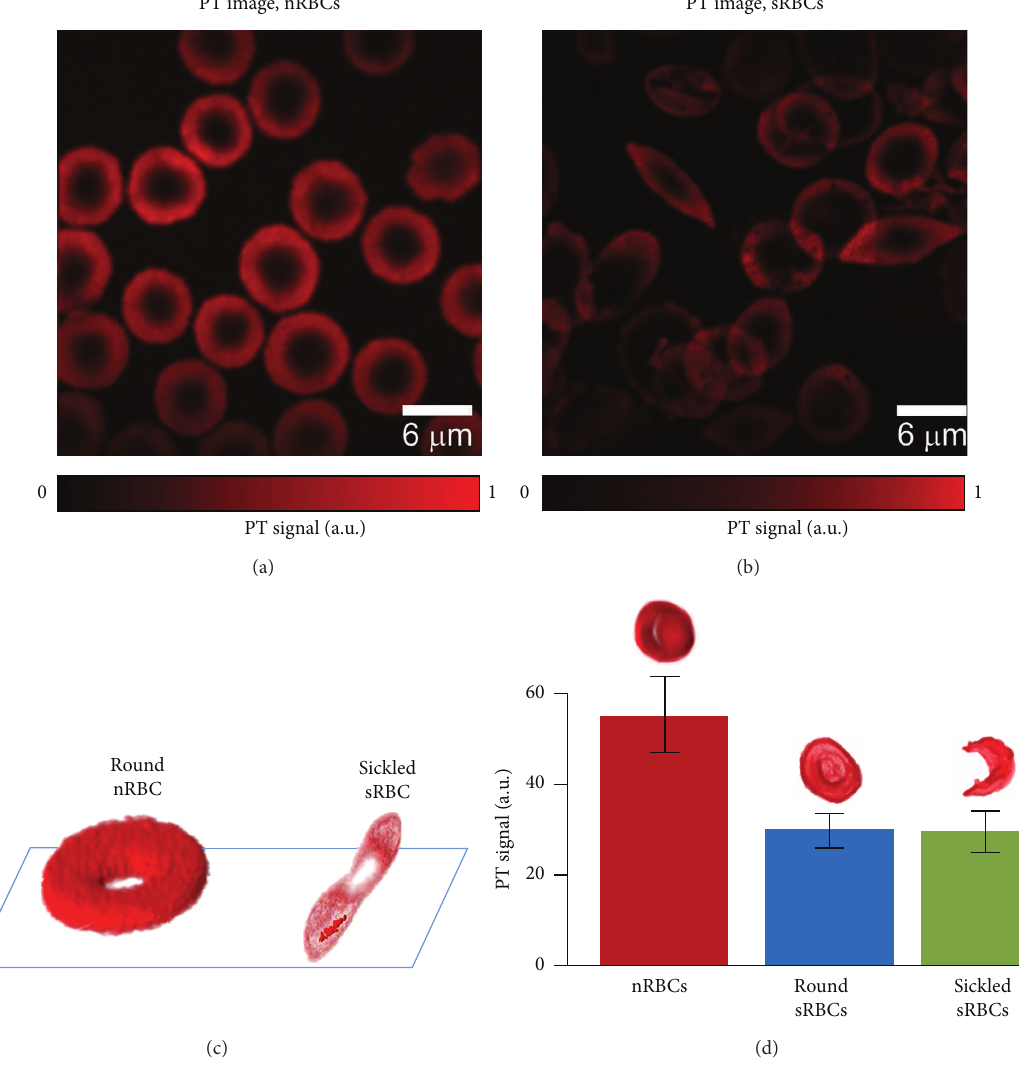
Figure4:HighresolutionPTimagingofnRBCsandsRBCs invitro .(a,b)PTimagesofnRBCsandsRBCs.(c)3Dreconstructionofabsorption profile based on z-stack of multiple PT images for a healthy nRBC (left) and a single sickled sRBC (right). (d) PT signal amplitudes from individual nRBCs and sRBCs with round and deformed shape. Laser parameters: wavelength, 532 nm; energy fluence, 20 mJ/cm 2 ; laser beam diameter, 0.5 𝜇